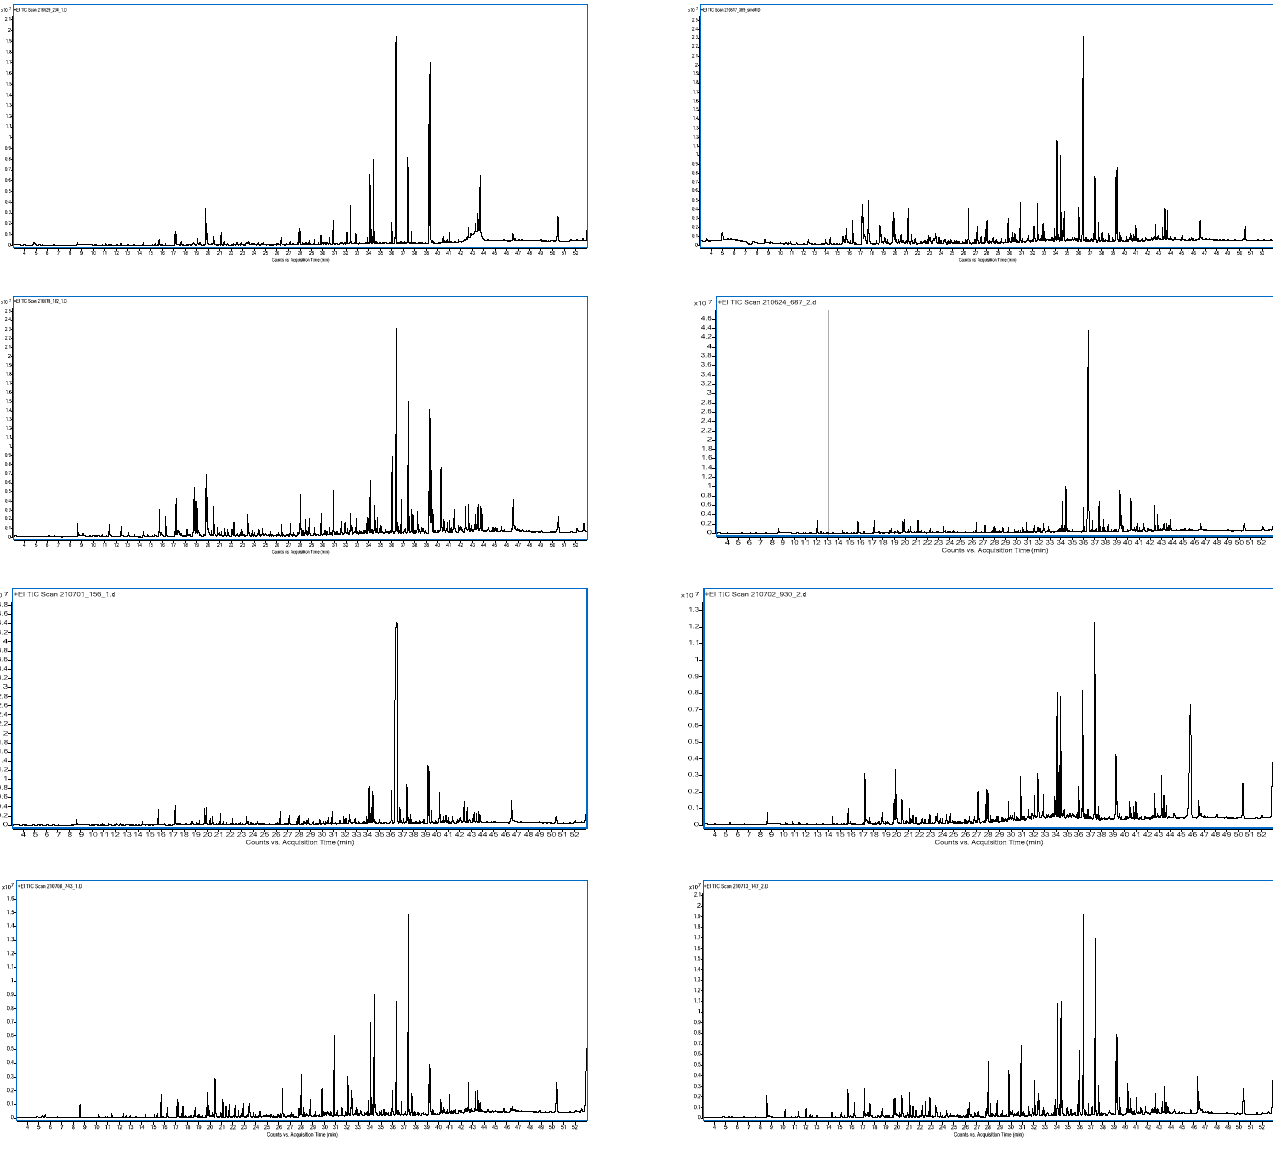
Figure A1. Total ion chromatograms of the tea samples.